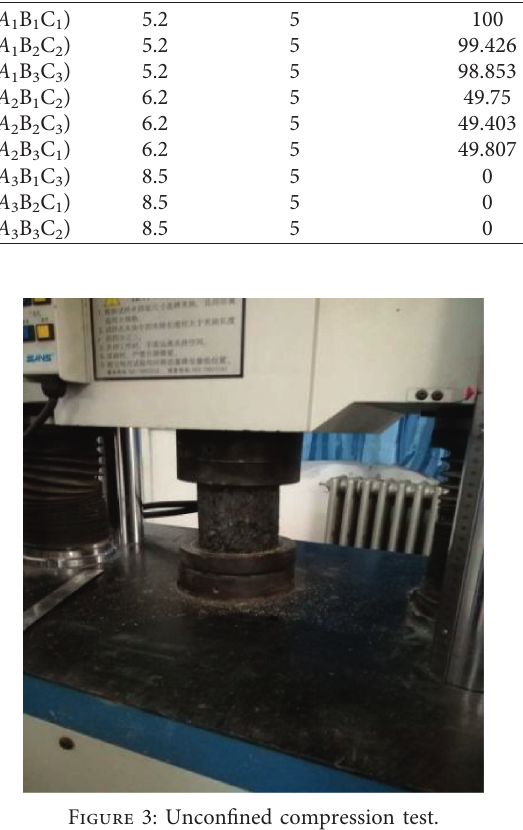
Figure 3: Unconfined compression test.